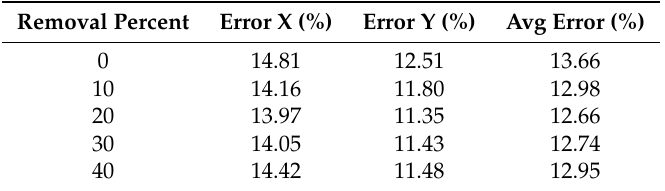
Table 6. Average errors for various removalPercent values for GT